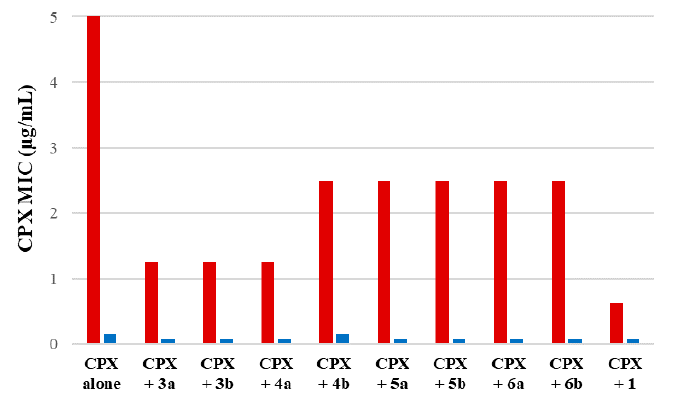
Figure 3. Synergistic assays of derivatives 3a , 3b , 4a , 4b , 5a , 5b , 6a and 6b and starting hit 1 at 12.5 µg/mL in combination with scalar concentrations of CPX against SA-1199B (red columns) and SA-1199 (blue columns).